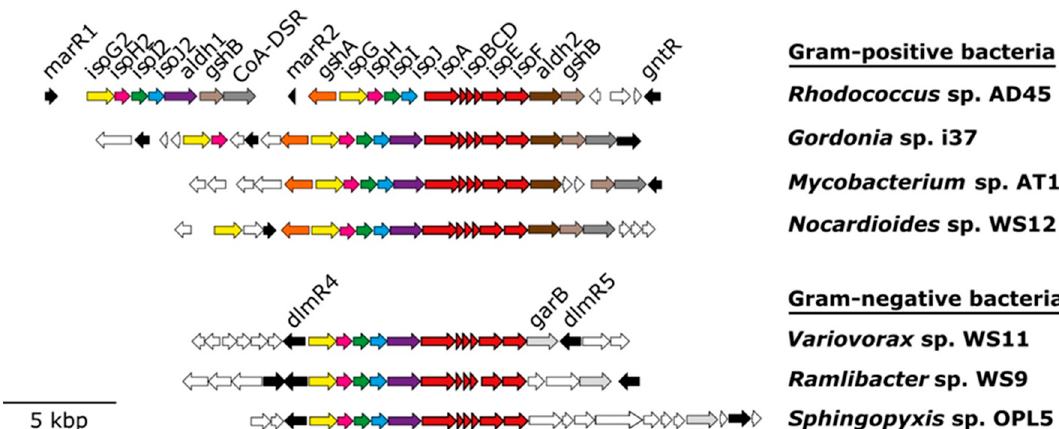
Figure 2. Isoprene degradation gene clusters from representative Gram-positive and Gram-negative isoprene-degrading bacteria. Genes encoding IsoMO ( isoABCDEF ) are coloured in red. Regulatory genes are shown in black. Adjacent genes not suspected to be involved in isoprene degradation are coloured in white.